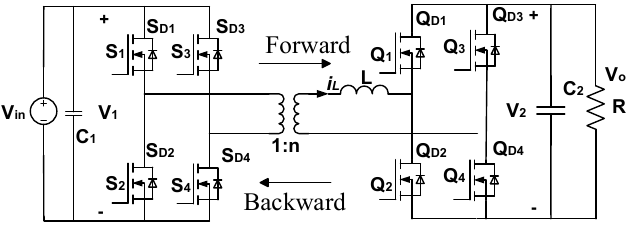
Figure 1. The topology of a DAB converter.